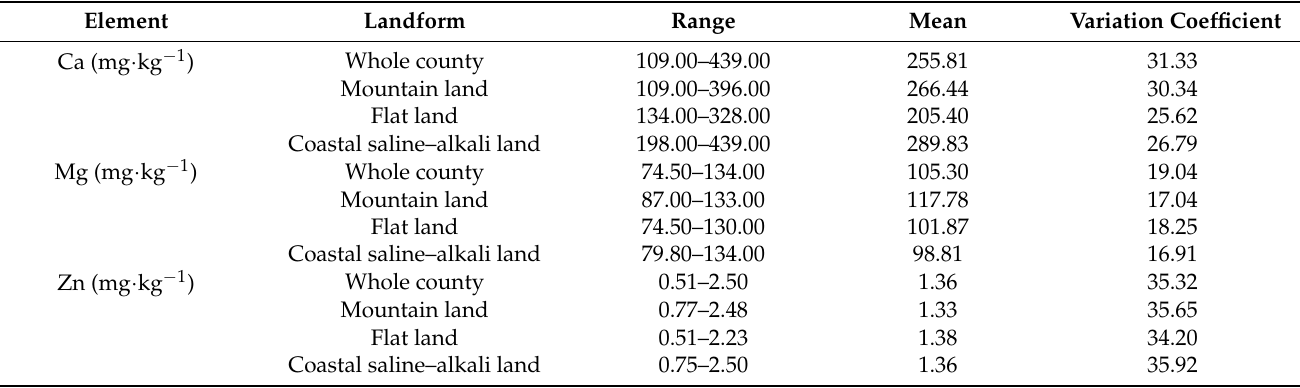
Table 1. The contents of mineral nutrients in citrus fruits in Xiangshan